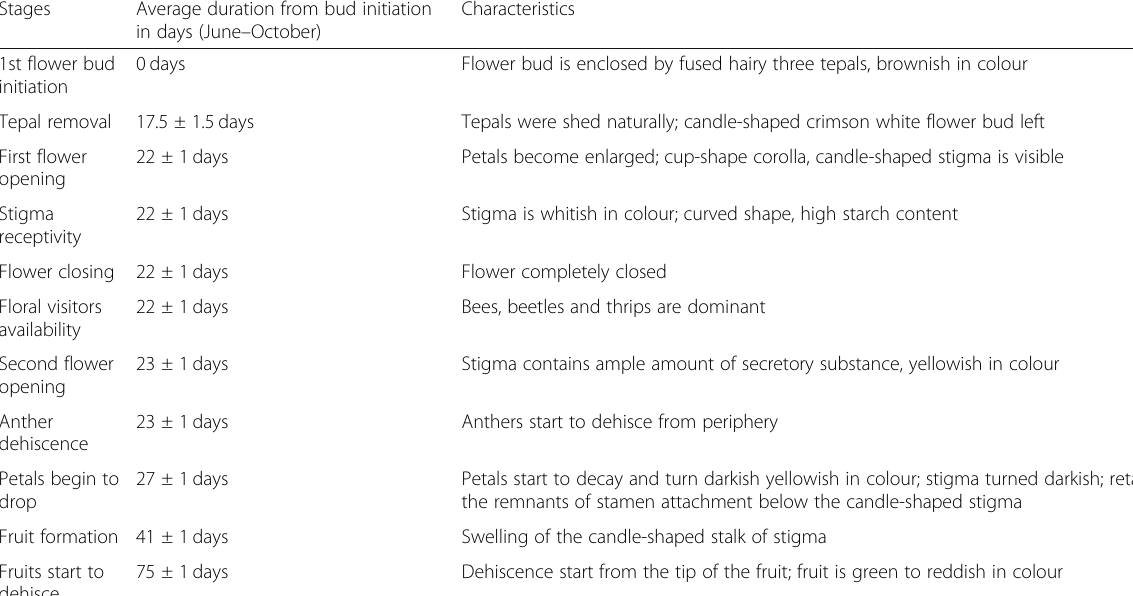
Table 1 Chronological events in reproductive stages of M . grandiflora Stages Average duration from bud initiation Characteristics in days (June – October)